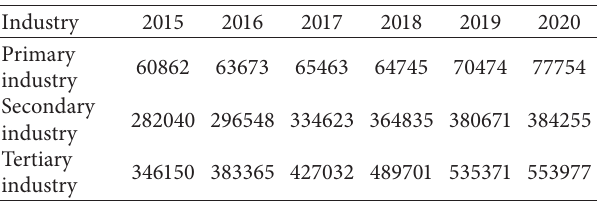
Table 2: Summary of calendar year data of the three major in- dustries (unit: 100 billion yuan).